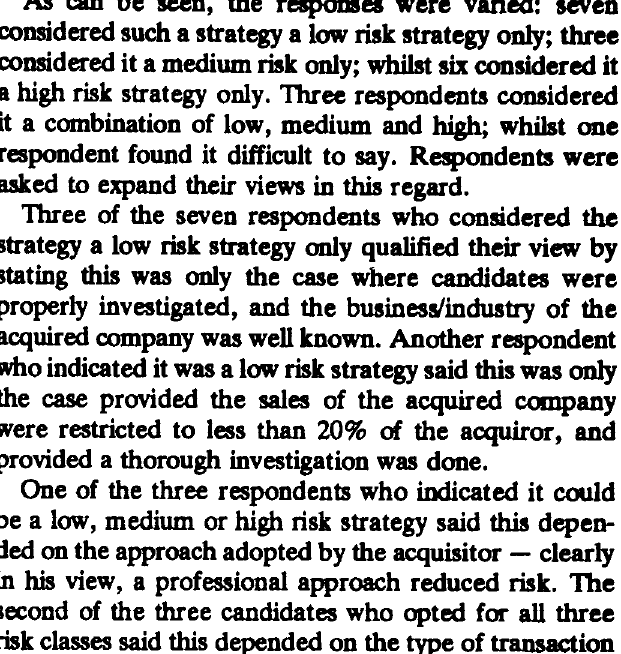
Table 4 Percentage of mergers/acquisitions considered